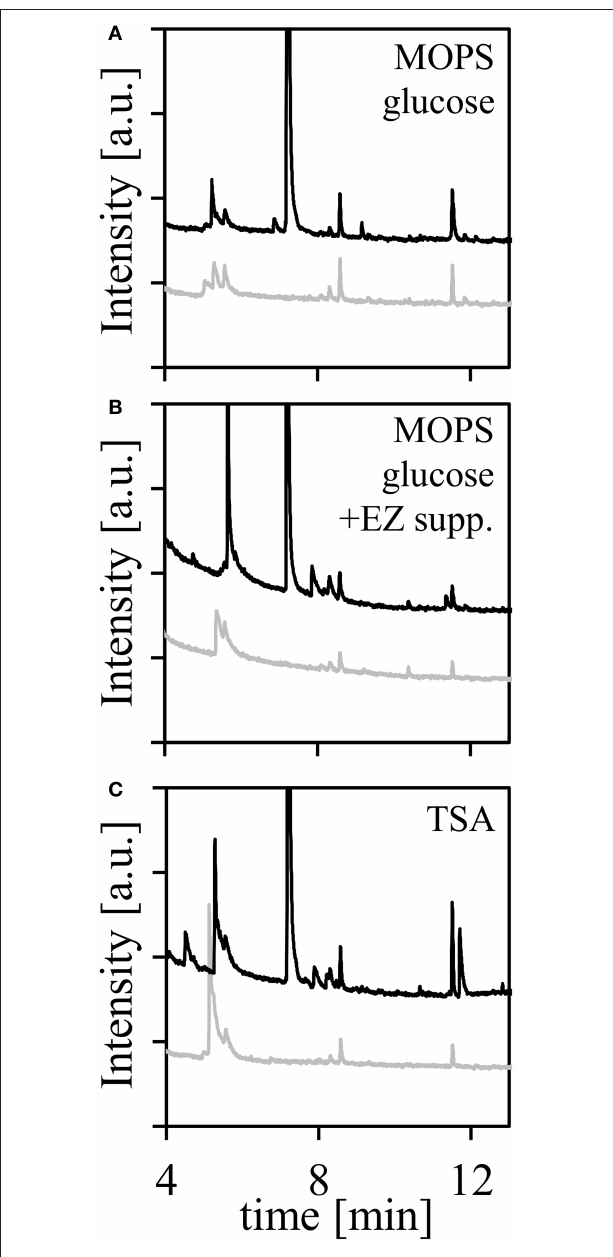
FIGURE 4 | Volatiles from P. aeruginosa PAO1 cultures on various media after 1 week incubation. Shown in light gray curves are uninoculated controls, and those in black curves are inoculated with PAO1 and are transposed for separation. (A) MOPS minimal media with glucose as the sole carbon source, (B) MOPS minimal media with glucose as sole carbon source and EZ supplement (amino acids), (C) tryptic soy agar.